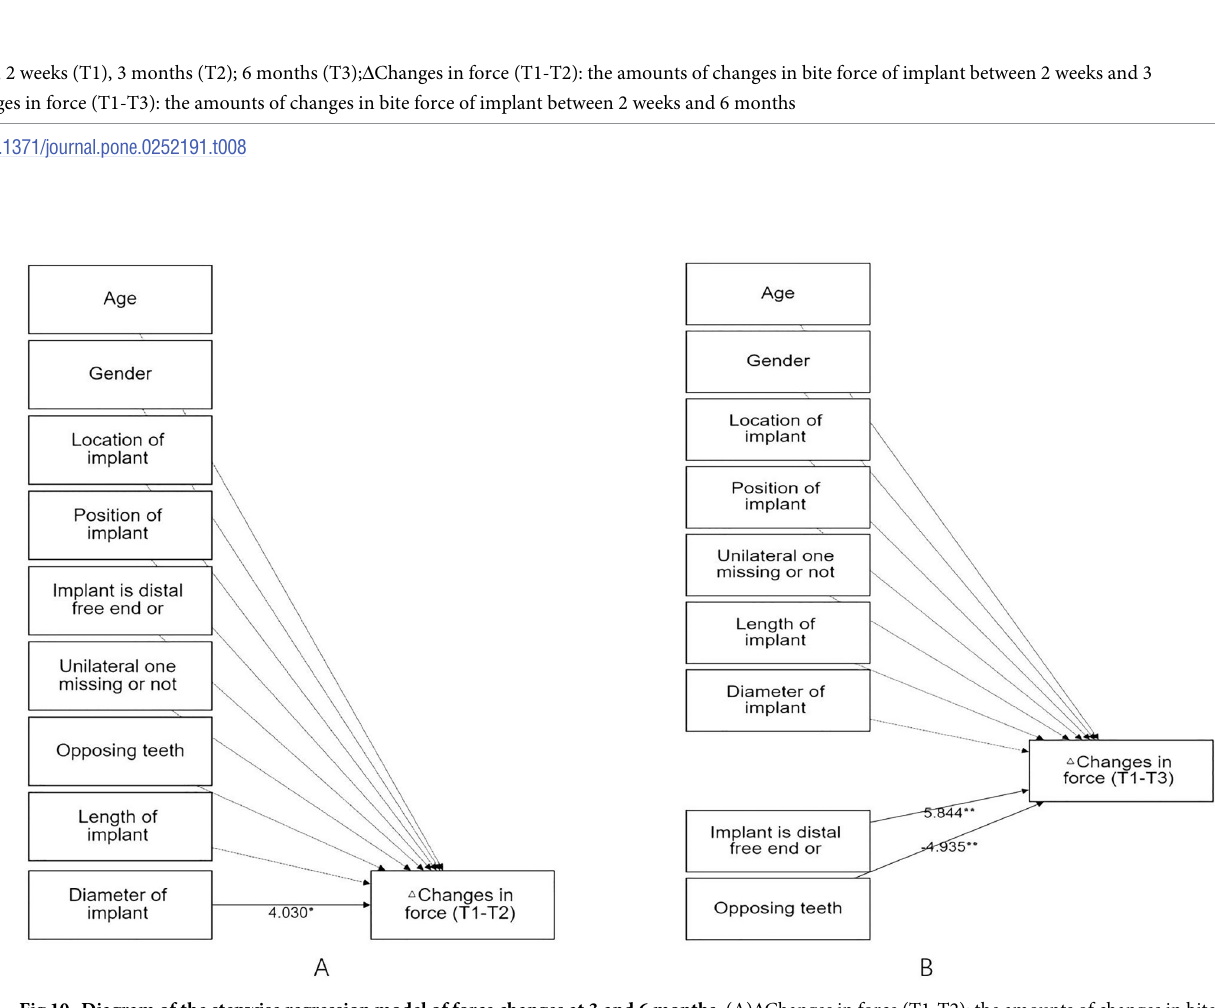
Fig 10. Diagram of the stepwise regression model of force changes at 3 and 6 months. (A) Δ Changes in force (T1-T2): the amounts of changes in bite force of implant between 2 weeks and 3 months; (B) Δ Changes in force (T1-T3): the amounts of changes in bite force of implant between 2 weeks and 6